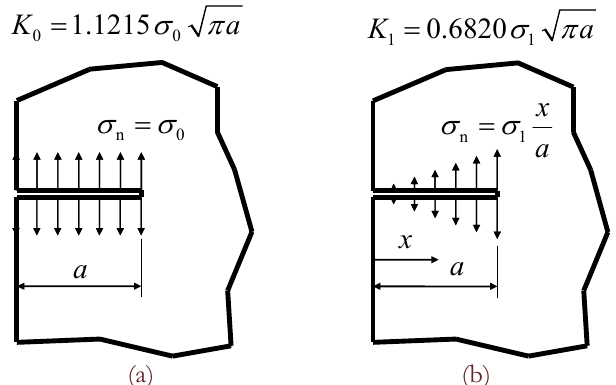
Figura 5: (a) Integrazione della WF con distribuzione di tensione nominale uniforme. (b) Integrazione della WF con distribuzione di tensione nominale variabile linearmente.